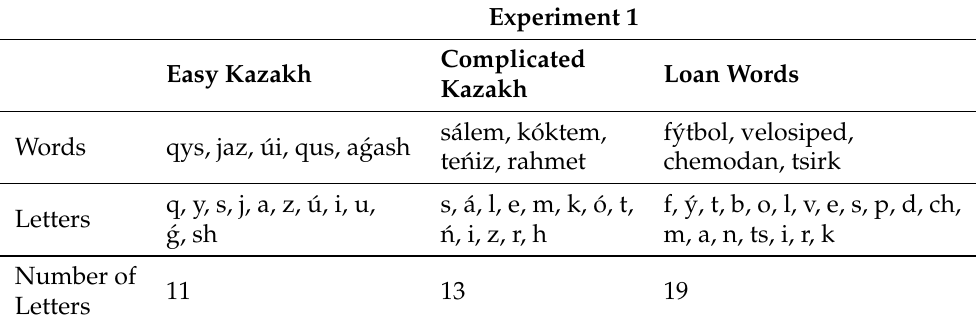
Table 1. Words and letters used in Experiment